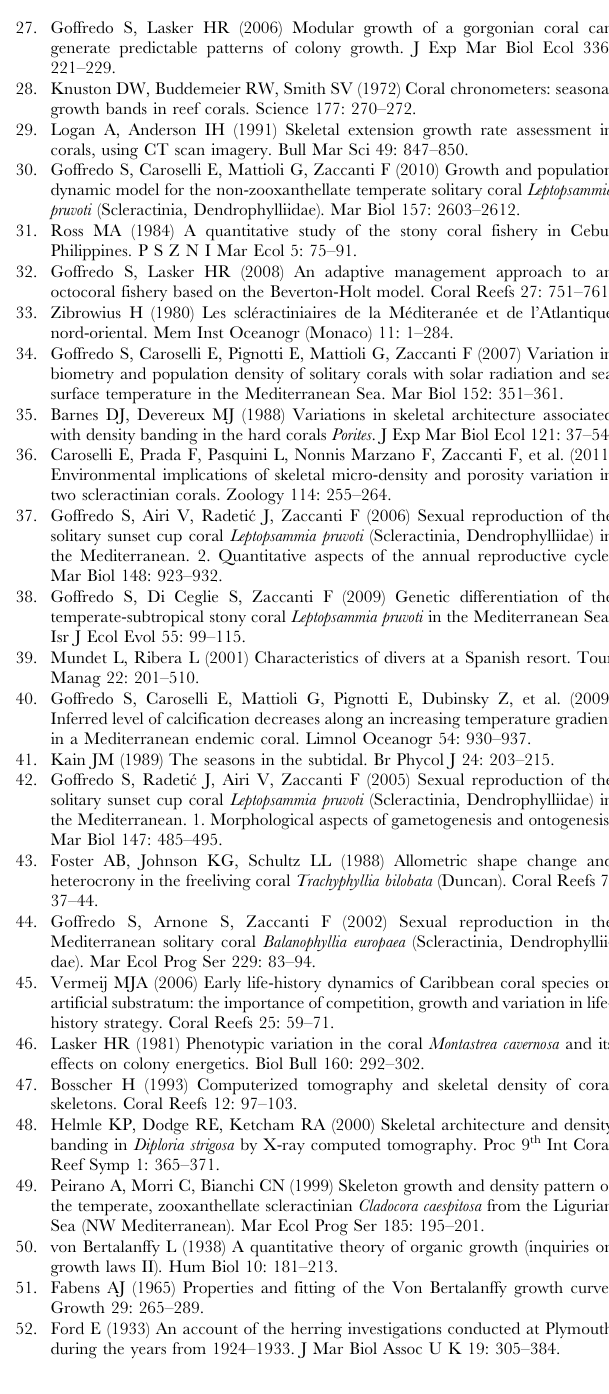
column shows correlation analyses between average daily SST and temperature at 16 m (left column) in the sampling sites for the indicated time interval. The right column shows SST (red line) and temperature at 16 m depth (black line) trends. n number of samples